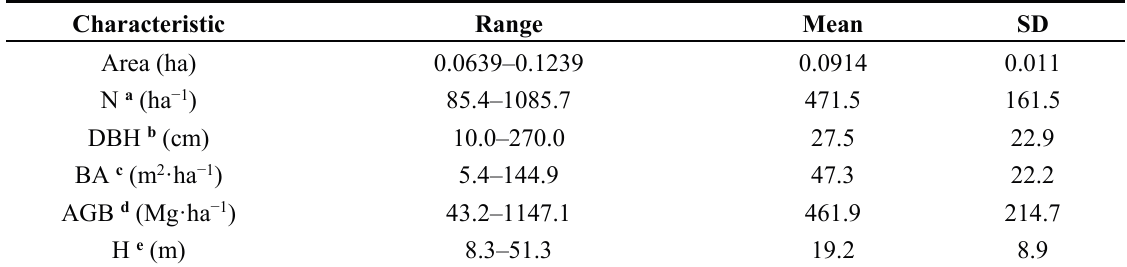
Table 1. Characteristics of 153 field